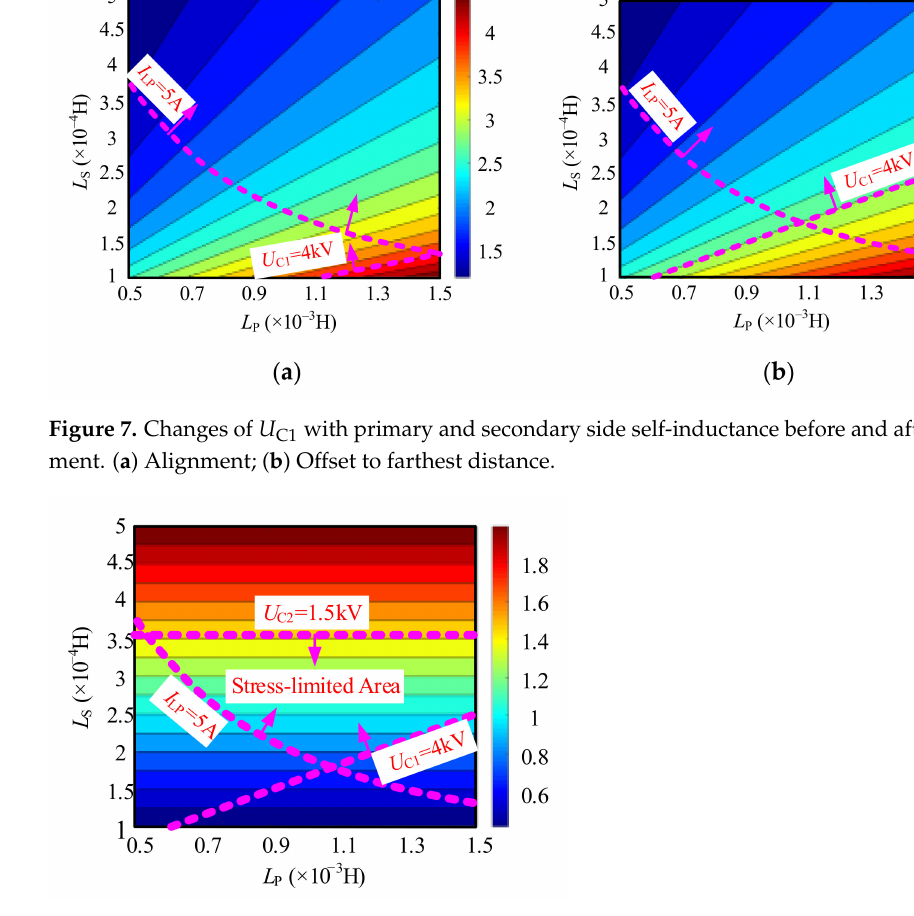
Figure 8. Changes of U C2 with primary and secondary side self-inductance before and after misalign- ment in